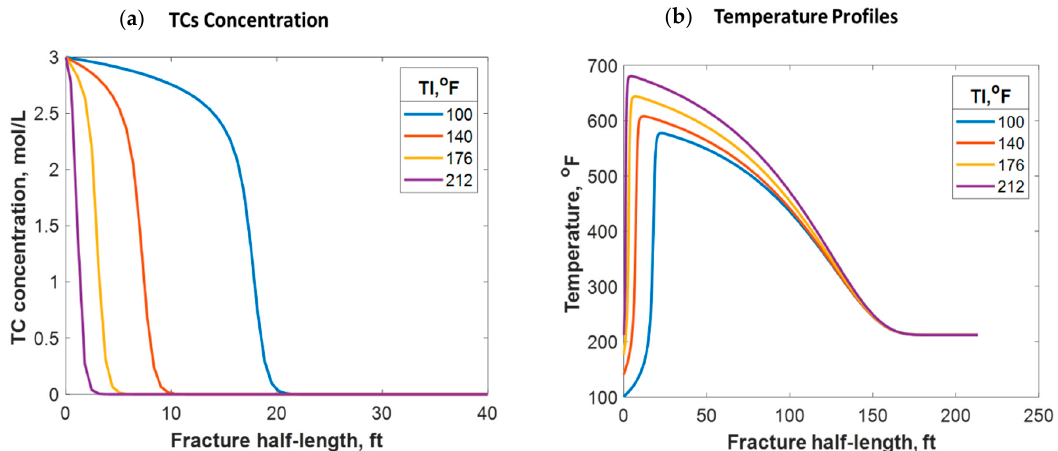
Figure 13. ( a ) TC concentrations and ( b ) fluid temperature profiles along the fracture half-length at different injection temperatures.